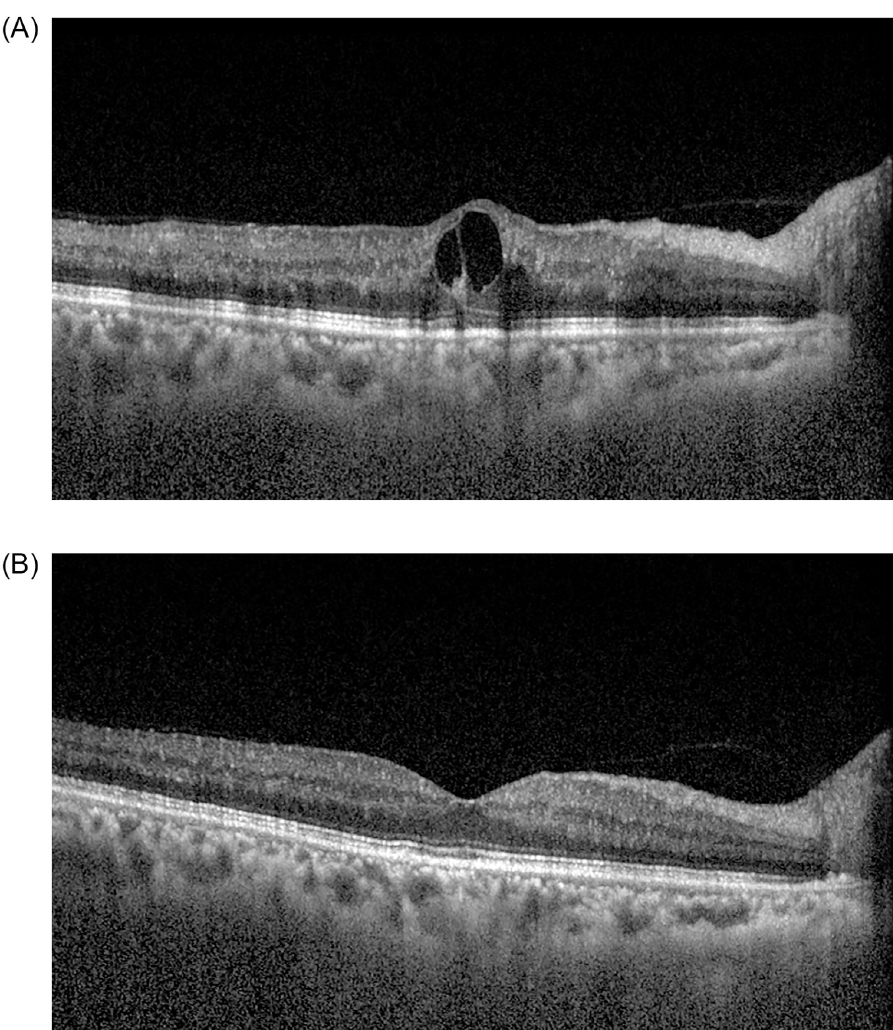
6.9 pg/mL one month after the first